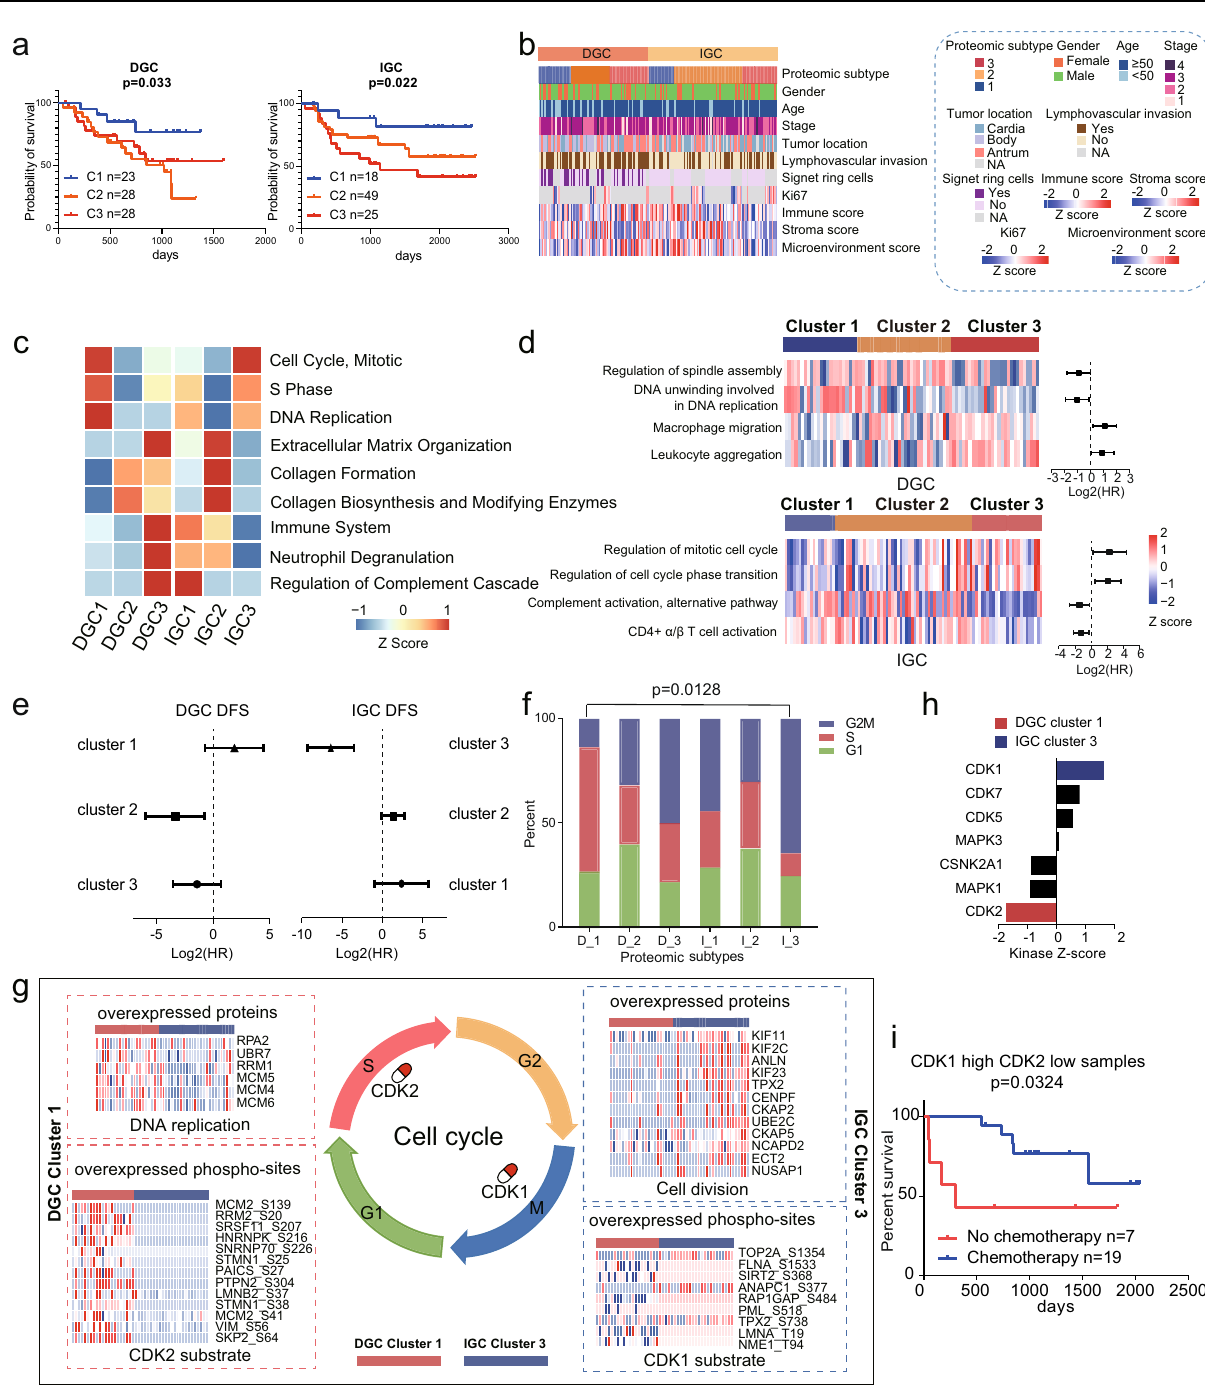
2)=6, n (DGC cluster 3)=7, n (IGC cluster 1)=6, n (IGC cluster 2)=13, and n (IGC cluster3)=5biologicallyindependentsamples.Thepointsanderrorbarsshowthe median of hazard ratio (HR) and 95% con fi dence interval (CI). f Percentage of patients with different cell cycle phases. The p -value is calculated by Fisher ’ s exact test. g SummaryofcellcycleregulationinDGCcluster1andIGCcluster3.Proteins involved in DNA replication and cell division in DGC cluster 1 and IGC cluster 3, phospho-sites of CDK1 and CDK2 substrates in DGC cluster 1 and IGC cluster 3 are shown, respectively. h KSEA analysis of CDKs kinase activities in DGC cluster 1 and IGC cluster 2. Kinases with p -value<0.05 (permutation test) are colored in red (CDK2, p -value=0.041) or blue (CDK1, p -value=0.049). i The assoc i ation of che- motherapy with DFS in GC patients with high CDK1 and low CDK2 level. n (che- motherapy)=19 and n (no chemotherapy)=7 biologically independent samples. The p -value is from Log-rank test. Source data are provided as a Source Data fi